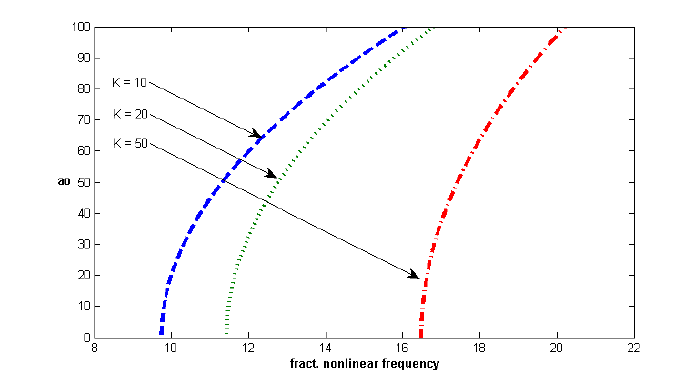
Figure 7. Fractional nonlinear frequency versus amplitude for different values of K ( α = 0.5, Kp = 5, Cp = 0.001, η = 0.5).